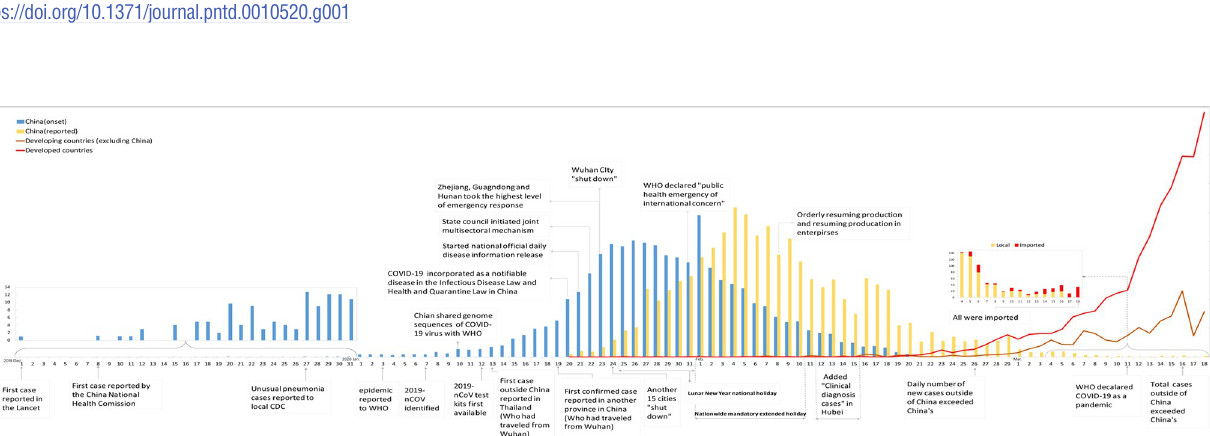
(Table 1 is referred for more details.) CDC, Centers for Disease Control and Prevention; COVID-19, coronavirus disease 19; 2019s-nCoV, 2019 novel coronavirus. Daily numbers of confirmed cases are plotted in bars by the date of onset (blue) and by that of diagnosis/reporting (yellow). In the inset are cases in December 2019 (left) and after March 5, 2020 (right). Cases reported outside of China were separately plotted between western coun- tries (red lines) and other countries (brown lines). The daily number of cases by the date of onset were adapted from the data in Fig 3 in the Report of the WHO–China Joint Mission on COVID-19 [6], the rest of the data are from China CDC [5], and the events are from various publications included in this paper. CDC, Centers for Disease Control and Prevention; COVID-19, coronavirus disease 19.